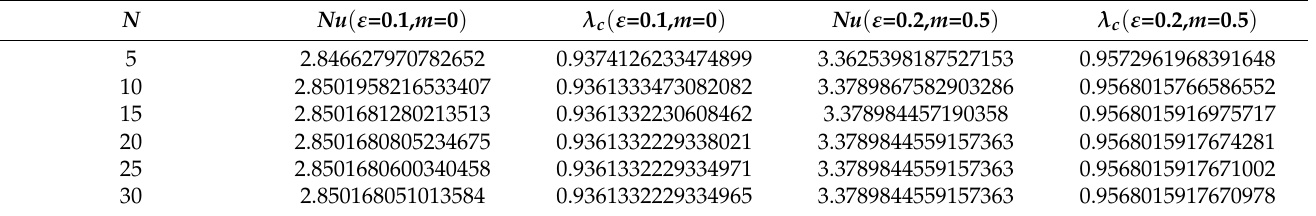
Table 3. Convergence of critical values α = κ = H = S = 0.1, γ = 1 = G = r .